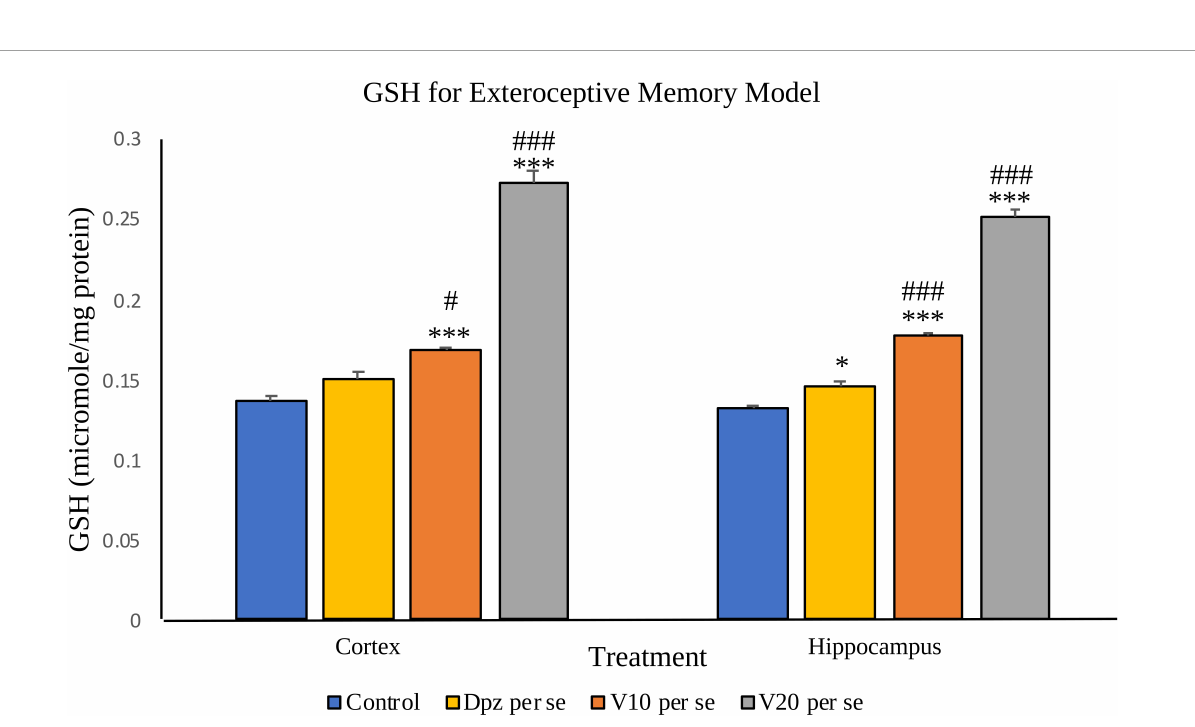
FIGURE9 Effect of vanillin and other treatments on GSH. Data are expressed as mean ± SEM. “***” denotes P < 0.001 with respect to the control group, and “*” denotes P < 0.05 with respect to the control group. “###” denotes P < 0.001 with respect to the standard treatment group, and “#” denotes P < 0.05 with respect to the standard treatment